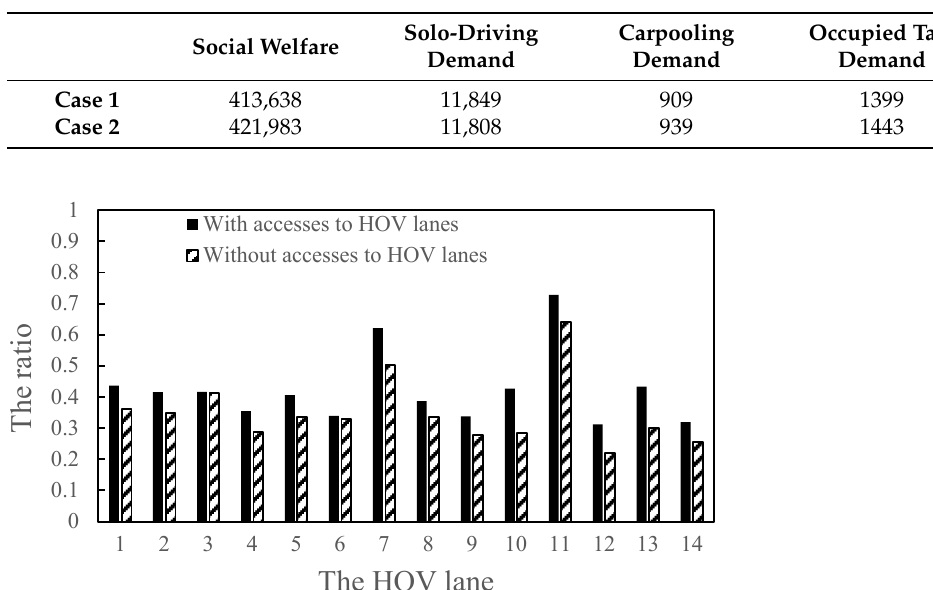
Table 3. The network performance in case 1 and case 2.